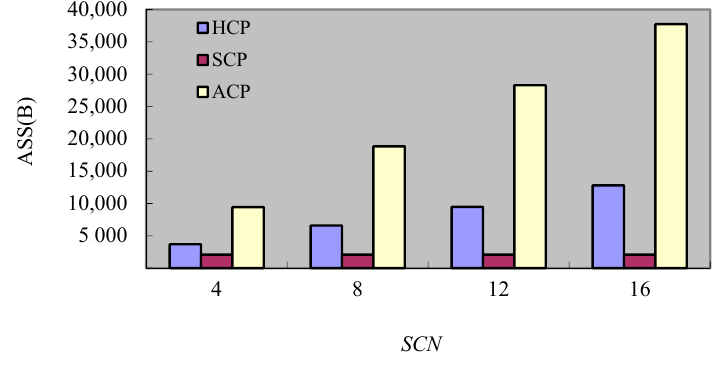
Figure 13. Impact of SCN on ASS.